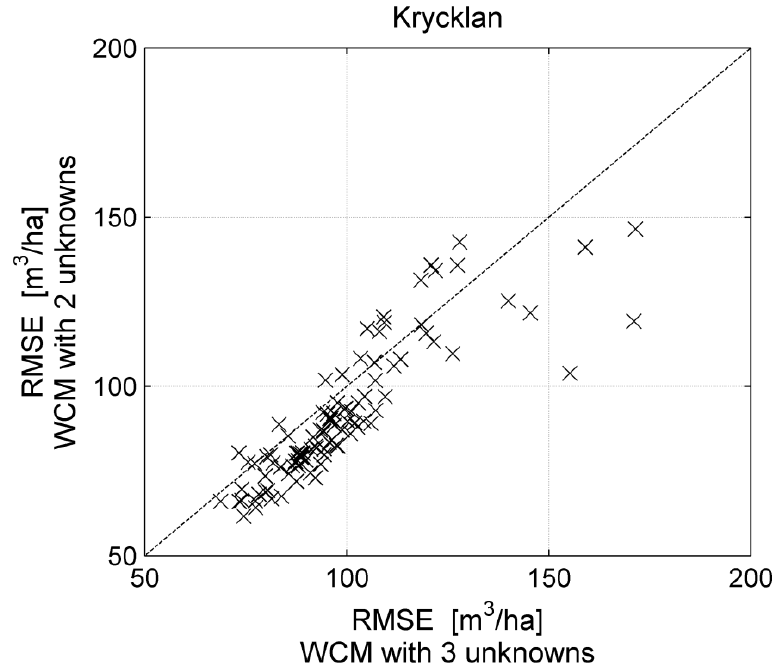
Figure 8. Scatter plot of single-image RMSEs for a model with three unknowns (horizontal axis) and a model with two unknowns where the parameter β was set a priori equal to 0.006 (vertical axis). Test site: